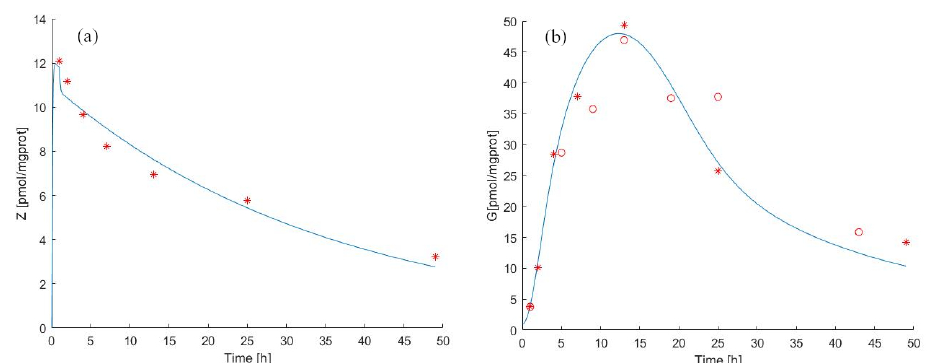
Figure 5. Model 2 simulation trend in the pulse experiment. Panel ( a ) shows the simulated zole- dronate ( ZA ) trend over time; panel ( b ) shows the simulated antigen ( IPP ) trend over time. The con- tinuous blue line represents the model forecast, while red asterisks represent the experimental data obtained by [39] and red circles represent the experimental data obtained by